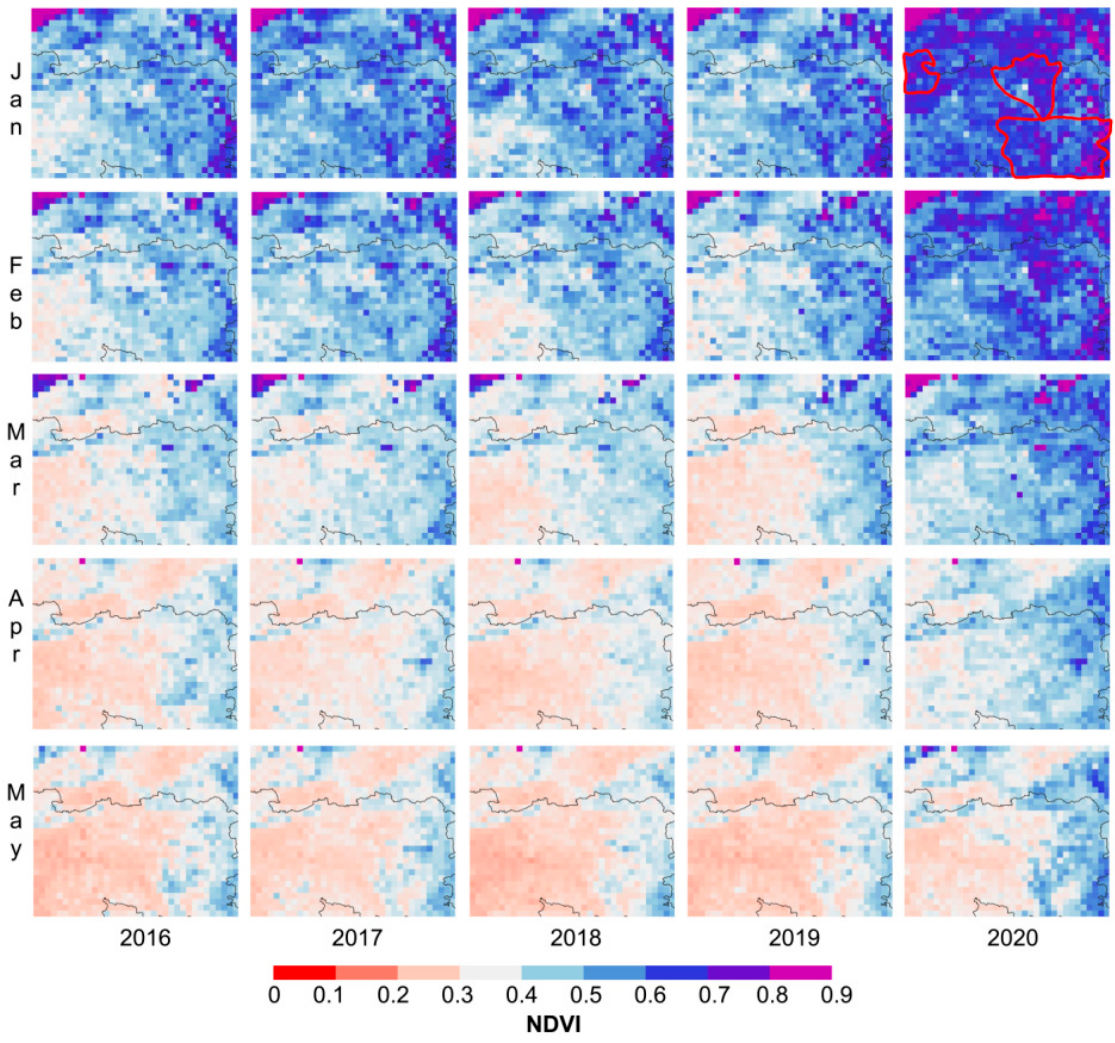
Figure 8. Normalized Difference Vegetation Index (NDVI) values in the study area during January to May in 2016–2020.